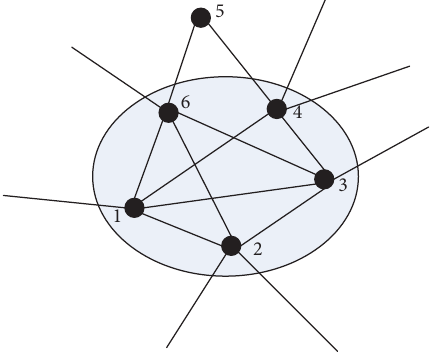
Figure 2: The discovery of minimal cluster.